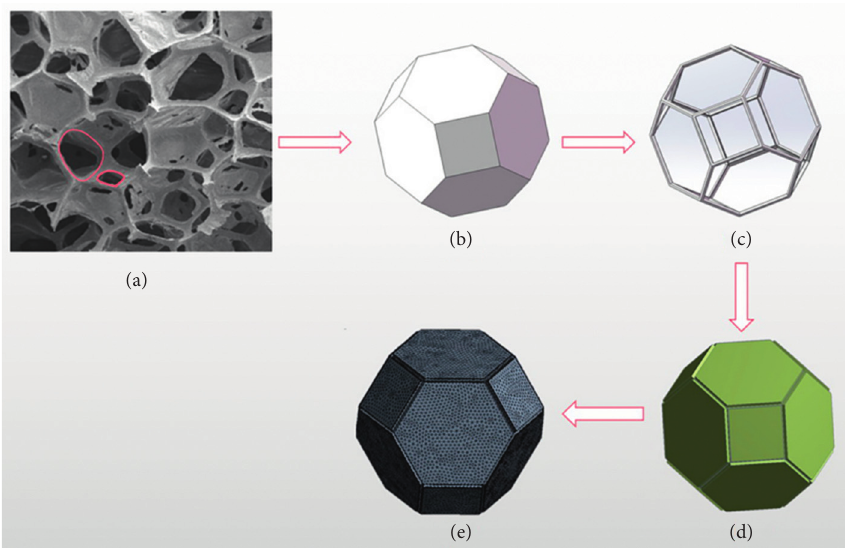
Figure 4: The process of establishing a single-hole acoustic cavity model.